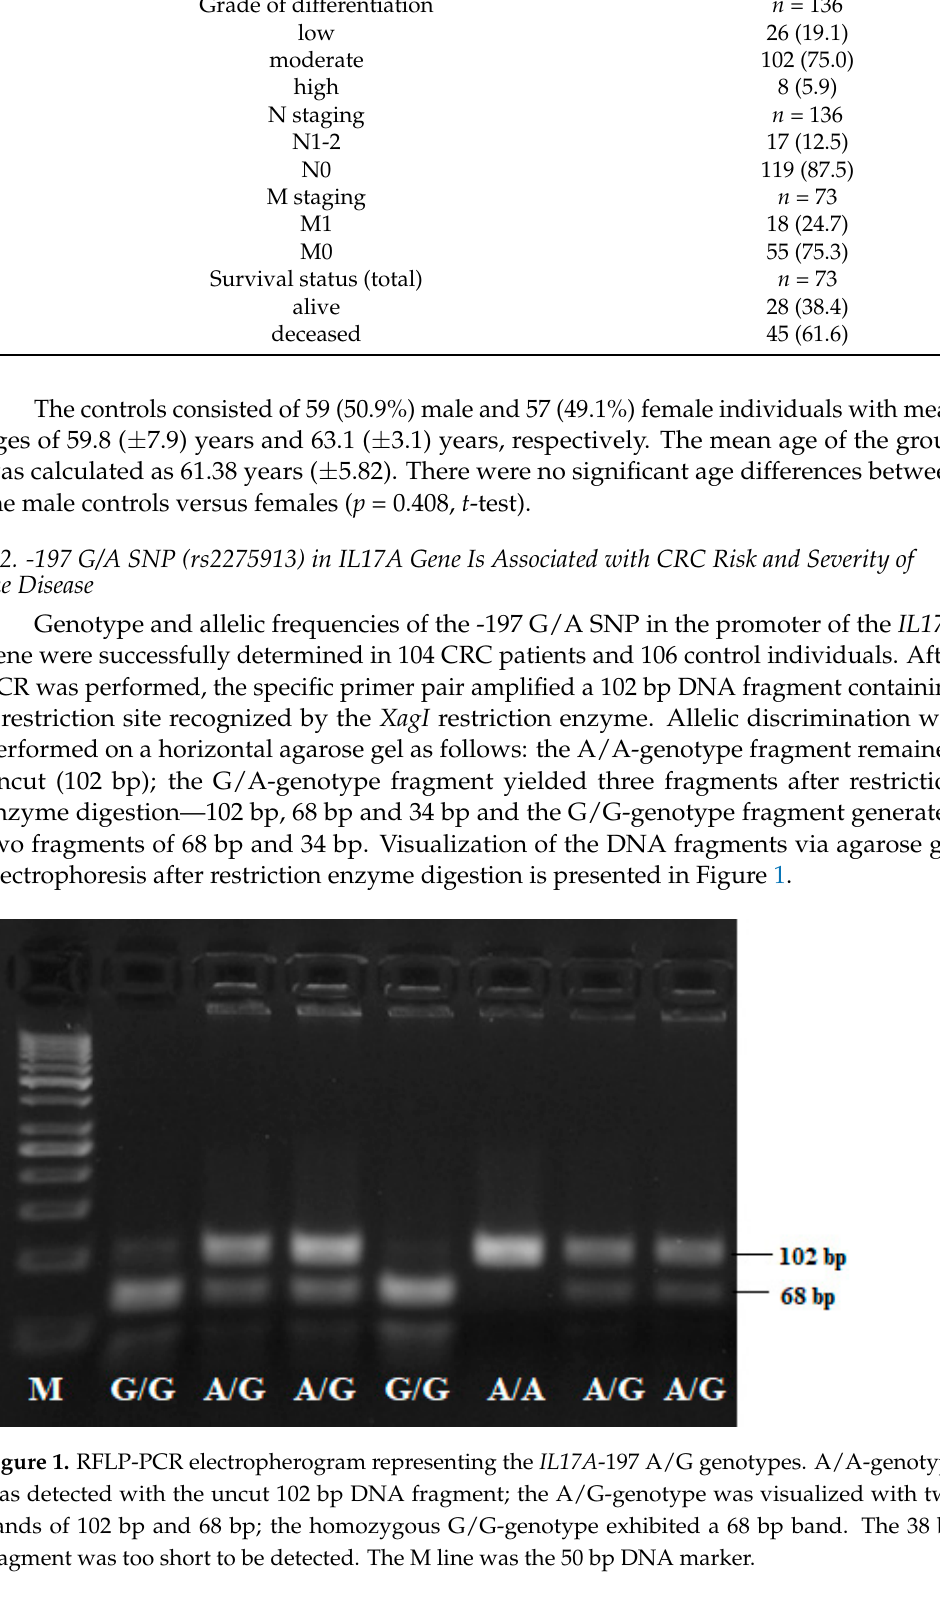
Table 3 . Distribution of genotype and allelic frequencies of the IL17A -197 A/G SNP between CRC cases and controls.